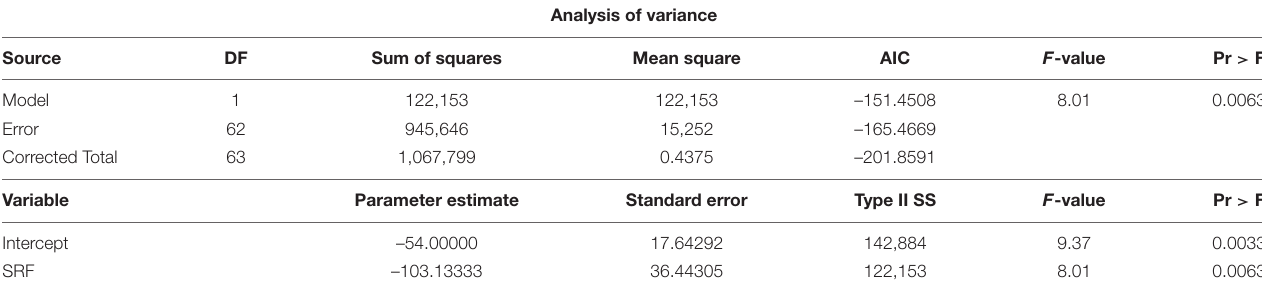
FIGURE 5 | Model using OCT biomarkers as predictors of CRT improvement greater than 100 µ m after treatment (multivariate logistic regression): the presence of SRF at baseline favored an outcome with CRT improvement > 100 µ m [SRF (+) vs. (-): odds ratio 6.16 (1.75–21.6)]. TABLE 3 | Model using OCT biomarkers as predictors to predict extent of CRT improvement ( (cid:49) CRT) after treatment (multiple regression). Analysis of